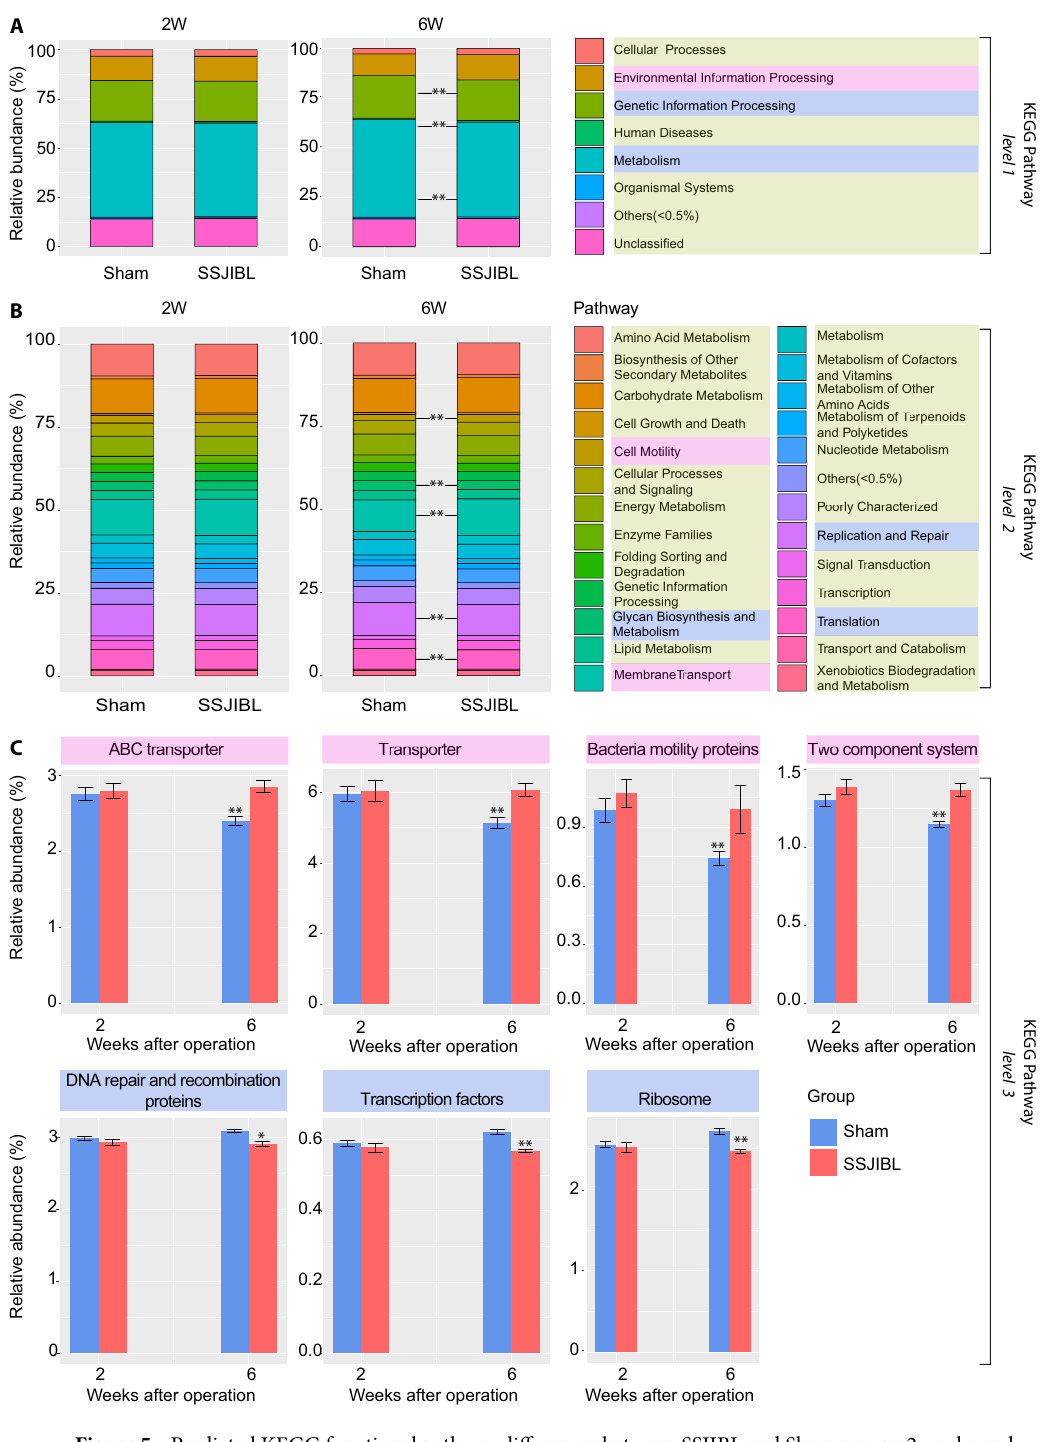
Figure 5. Predicted KEGG functional pathway differences between SSJIBL and Sham groups 2 weeks and 6 weeks postoperation. PICRUSt was used to predict functional potential of microbiomes using 16S rDNA gene sequence data. ( A ) KEGG functional pathway differences at level 1. ( B ) KEGG functional pathway differences at level 2. ( C ) KEGG functional pathway differences at level 3. Error bars are expressed as means ± SEM. Statistical significance was determined by two-tailed Student’s t test. * P < 0.05, ** P <